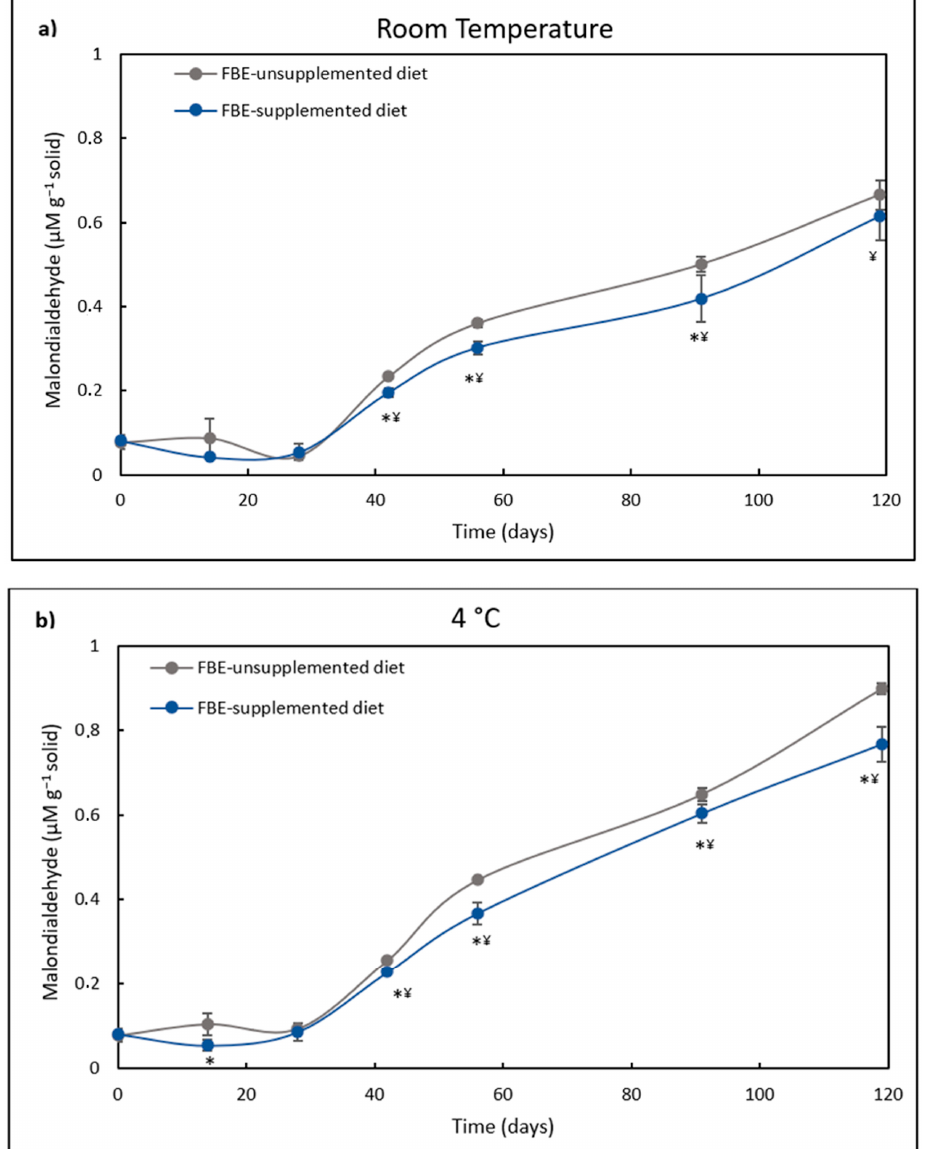
Figure 4. ( a ). Lipid peroxidation ( µ M g − 1 solid) of FBE-supplemented diet and FBE-unsupplemented diet (control diet) over storage time (days) at room temperature (RT). The results represent the average of three independent experiments and the error bars represent SD. The asterisk denotes a significant difference ( p < 0.05) between both diets at each time. ¥ denotes a significant difference ( p < 0.05) from the initial lipid peroxidation level. ( b ). Lipid peroxidation ( µ M g − 1 solid) of FBE-supplemented diet and FBE-unsupplemented diet (control diet) over storage time (days) at 4 ◦ C. The results represent the average of three independent experiments and the error bars represent SD. The asterisk denotes a significant difference ( p < 0.05) between both diets at each time. ¥ denotes a significant difference ( p < 0.05) from the initial lipid peroxidation